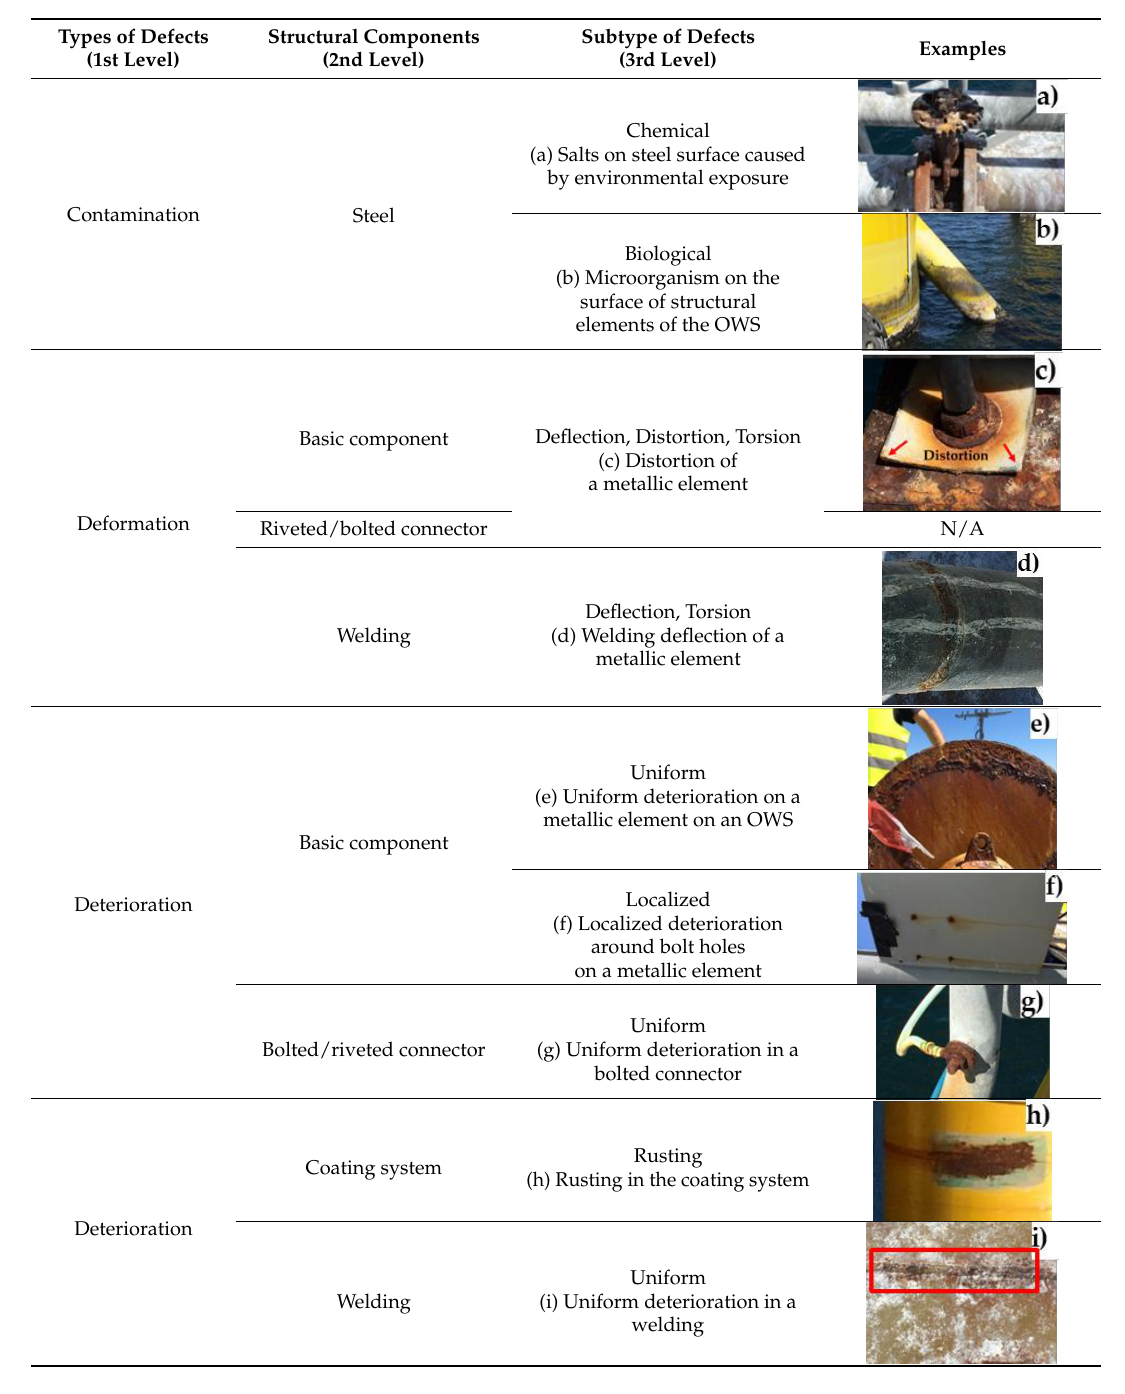
Table 12. Classification of defects in steel structures and some